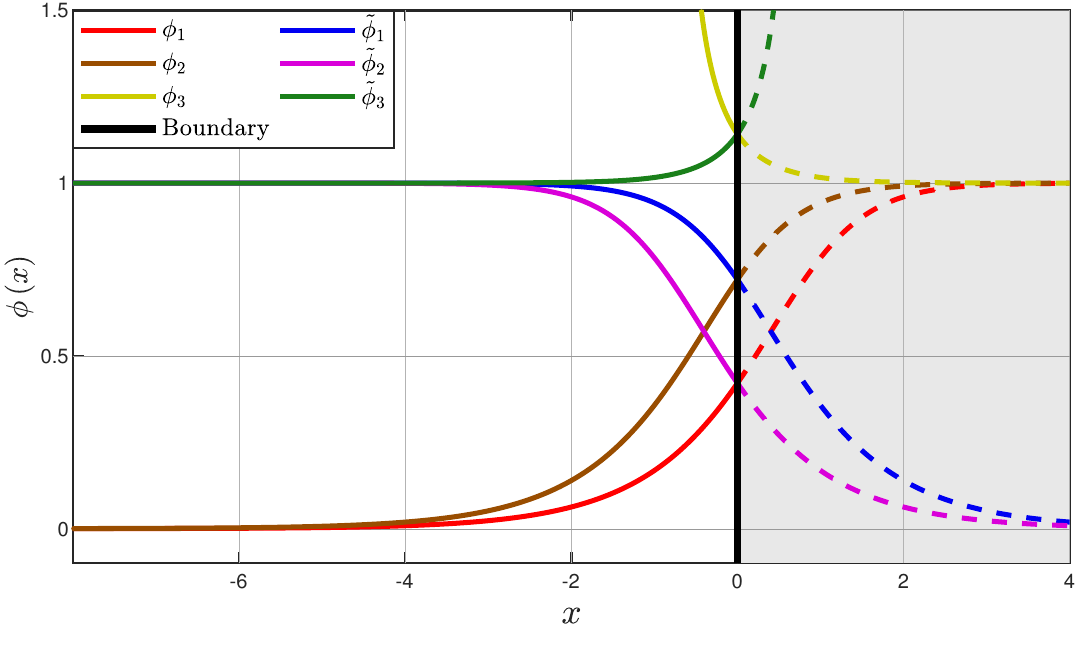
Figure 5 . Static solutions for